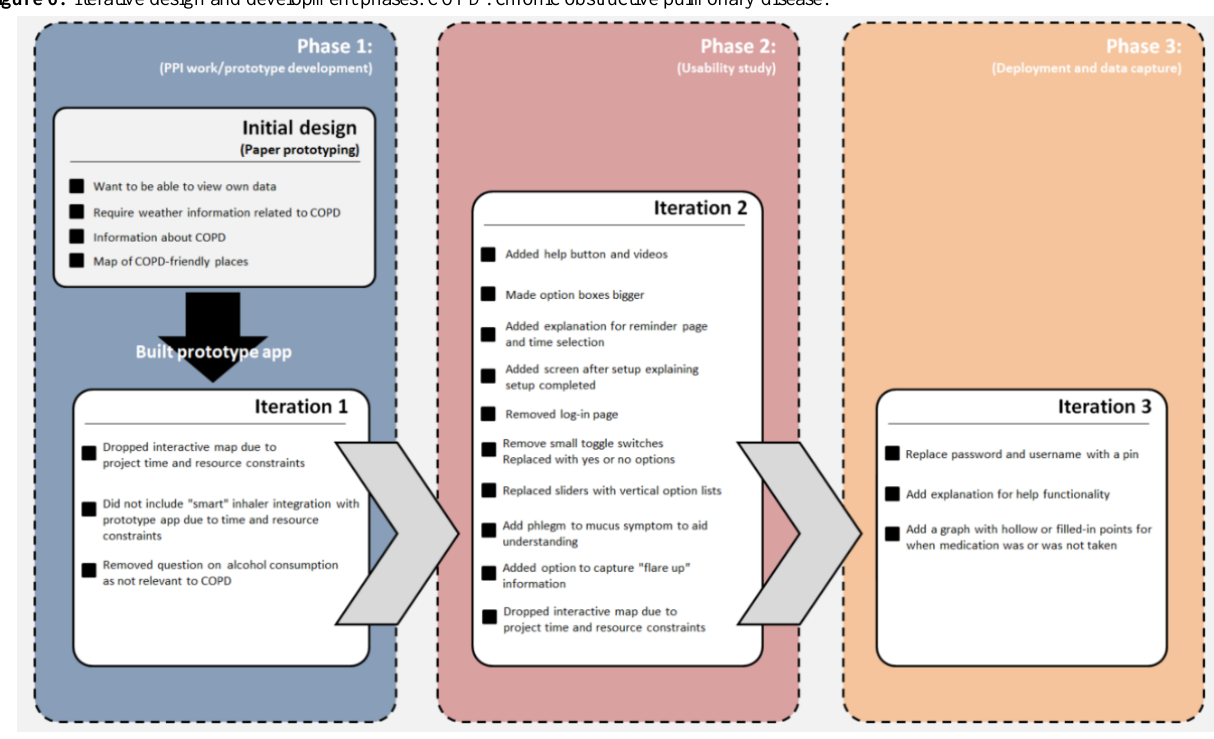
Figure 6. Iterative design and development phases. COPD: chronic obstructive pulmonary